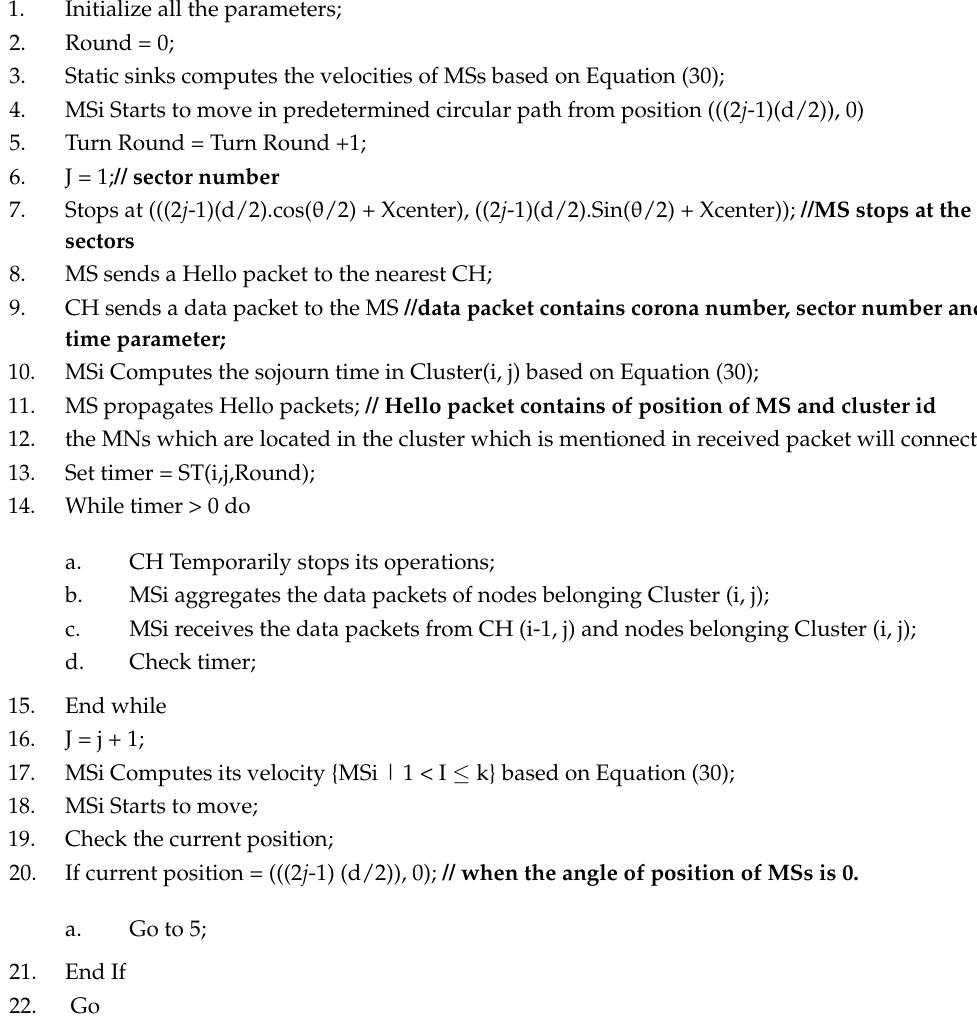
Algorithm 1 Circular Motion of MSs with Varied Velocity